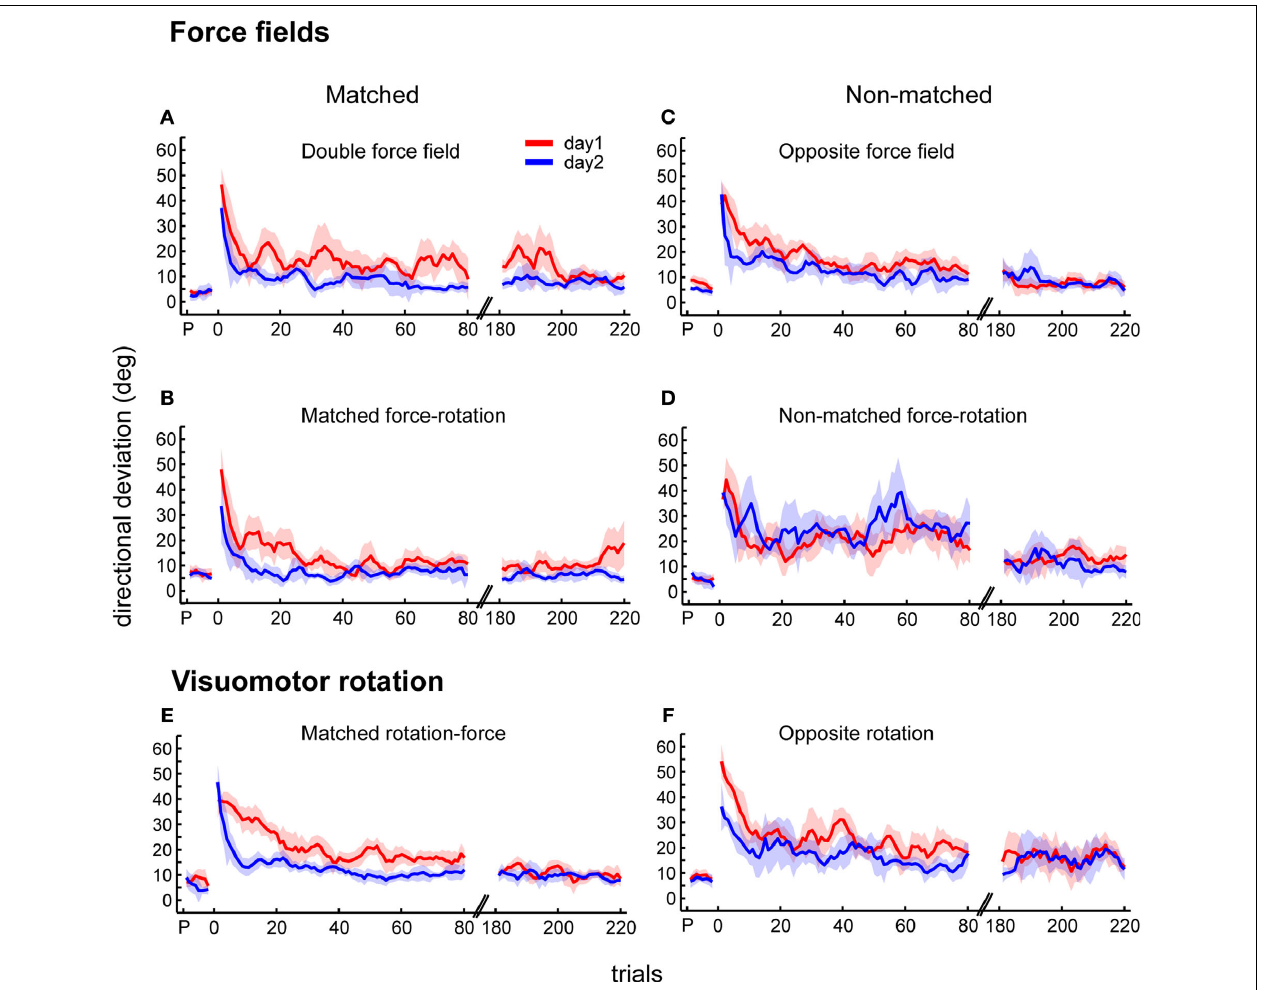
FIGURE 6 | Adaptation and retention of force fi elds and visuomotor rotations. Day1 and day2 time courses, showing trial-by-trial means and ± 1 SEM of initial directional deviations for the following groups: double force fi eld (A) , matched force-